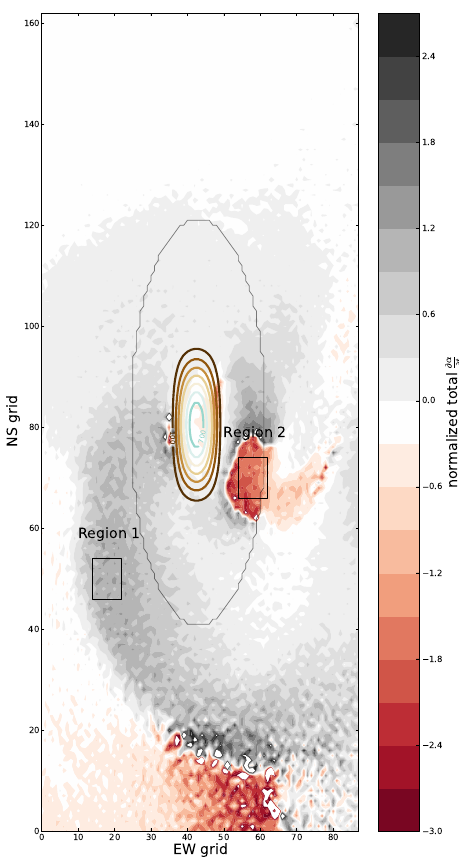
Figure 6. Total ∂α values are averaged over daytime hours. Also ∂t shown are elevation contours and the coastline. Regions 1 and 2 are identified for further dynamical